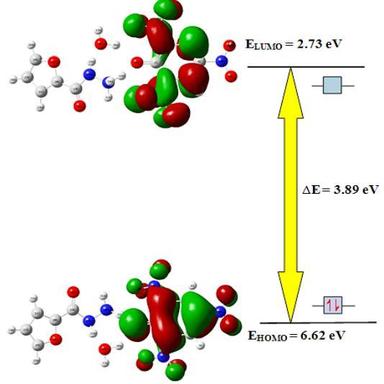
rfaces of Frontier Molecular Orbitals